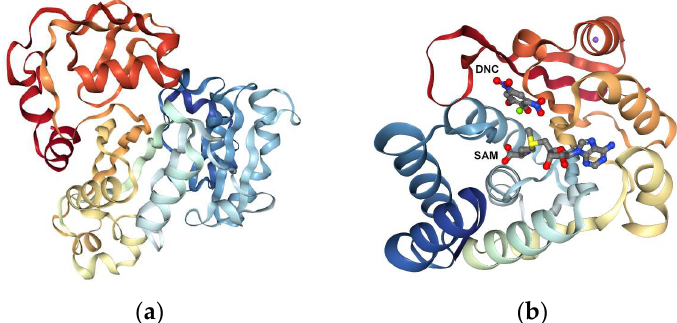
Figure 2. ( a ) The structure of an As(III) S-adenosylmethionine methyltransferase: insights into the mechanism of arsenic biotransformation (4FS8). ( b ) Crystal structure of human catechol O-methyltransferase chain: A with bound SAM (S-adenosyl methionine) and DNC (PDB code: 3BWM).